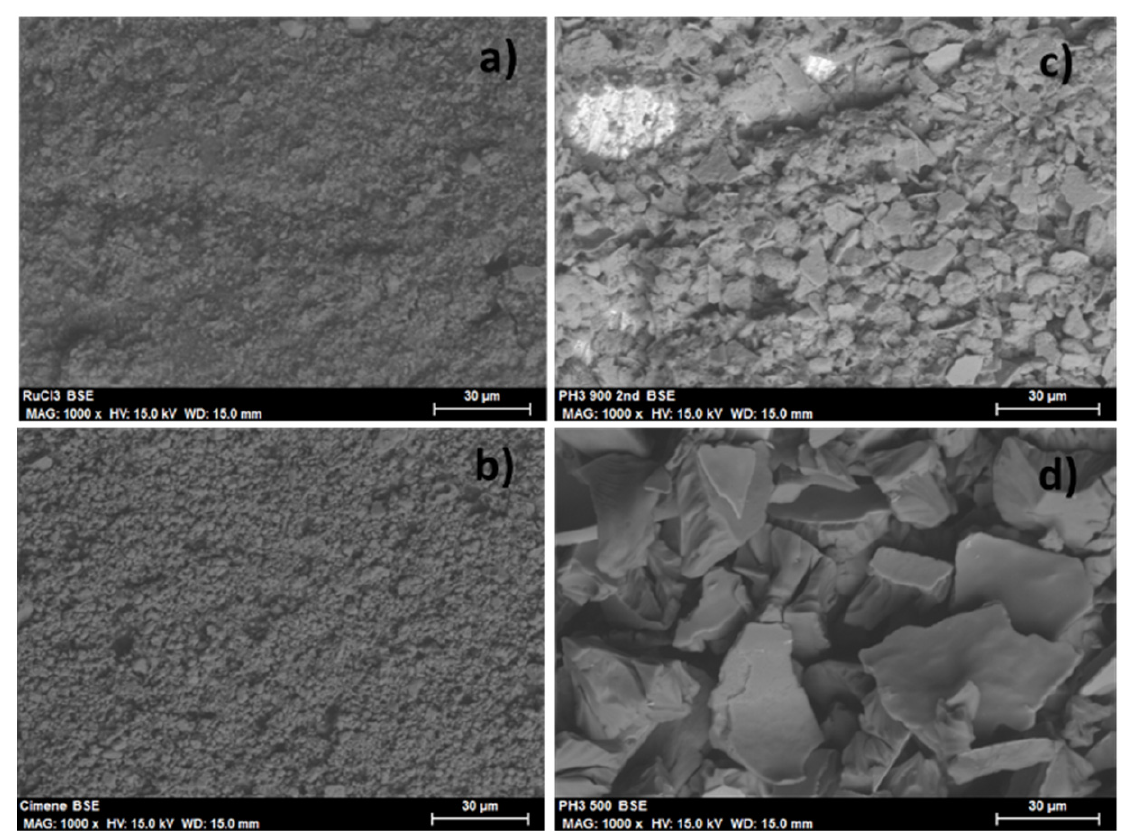
Figure 1a,b depict minor structural variations between RuO 2 [RuCl 3 ] and RuO 2 [Cym]. However, laminar forms are seen for the RuO 2 [PPh 3 ] obtained at 900 ◦ C (Figure 1c), which changes significantly from the spherical ones seen in the other two materials.